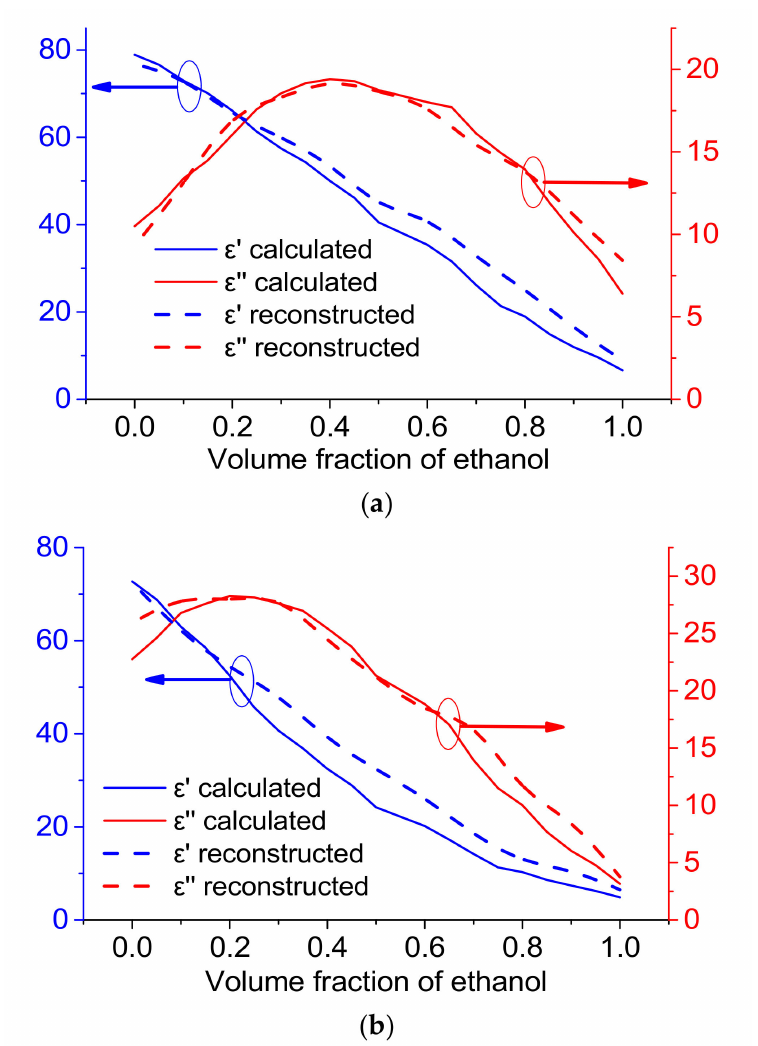
Figure 7. Reconstructed complex permittivity (real and imaginary parts) with respect to the volume